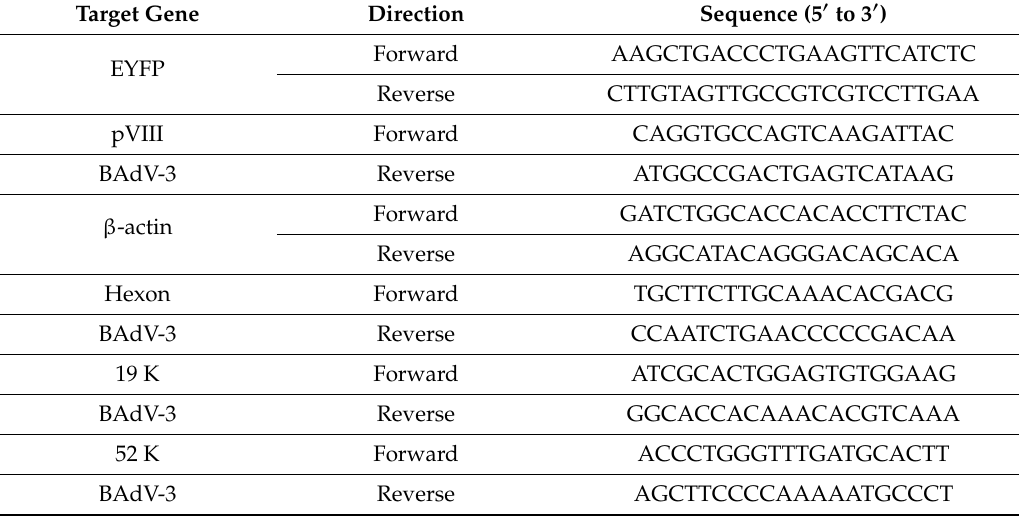
Table 3. List of